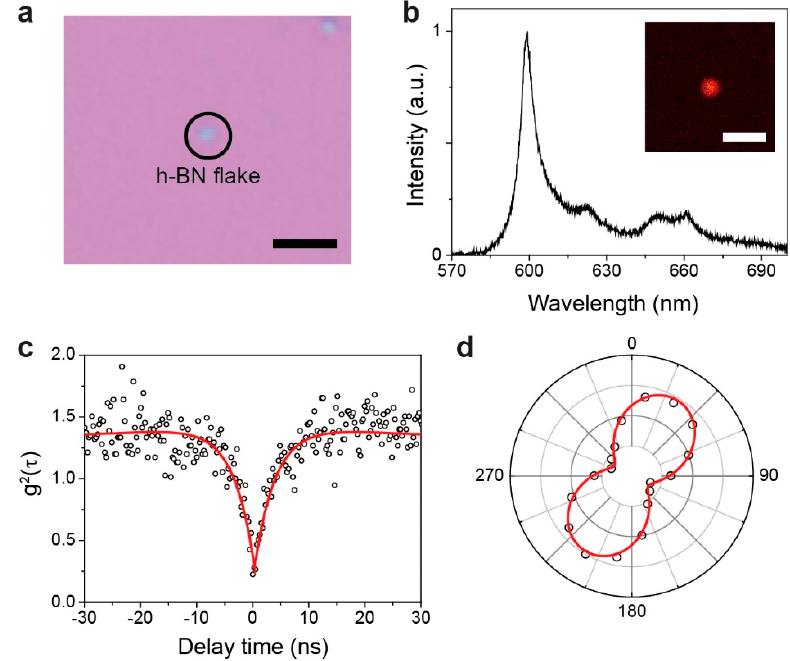
Figure 3. Experimental results. ( a ) Optical microscope image of a hexagonal boron nitride (h-BN) flake on the SiO 2 substrate. Scale bar, 2 µ m. ( b ) Measured spectrum of h-BN by optical pumping at room temperature. The zero phonon line (ZPL) wavelength is 600 nm. The inset shows the confocal photoluminescence (PL) image of single-photon emission. Scale bar, 1 µ m. ( c ) Measured second-order correlation function (g 2 ( τ )) of the single-photon emission in ( b ) (dots). The red line indicates the fitting curve using a three-level model equation. The value of g 2 (0) is 0.18. ( d ) Measured polarization of ZPL. The polarization visibility is 64%.